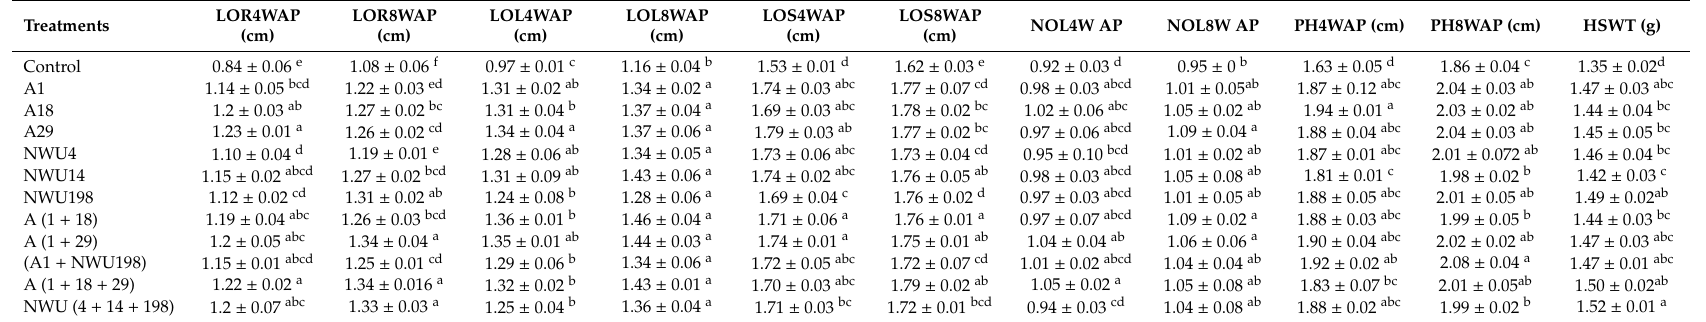
Table 3. Growth related traits at 4 th and 8 th weeks after